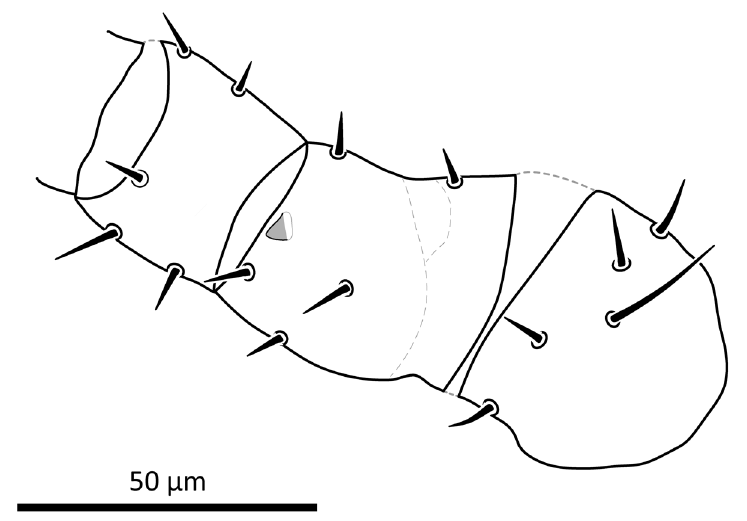
Figure 14. Zygoseius papaver sp. n., male, trochanter-genu II, ventral